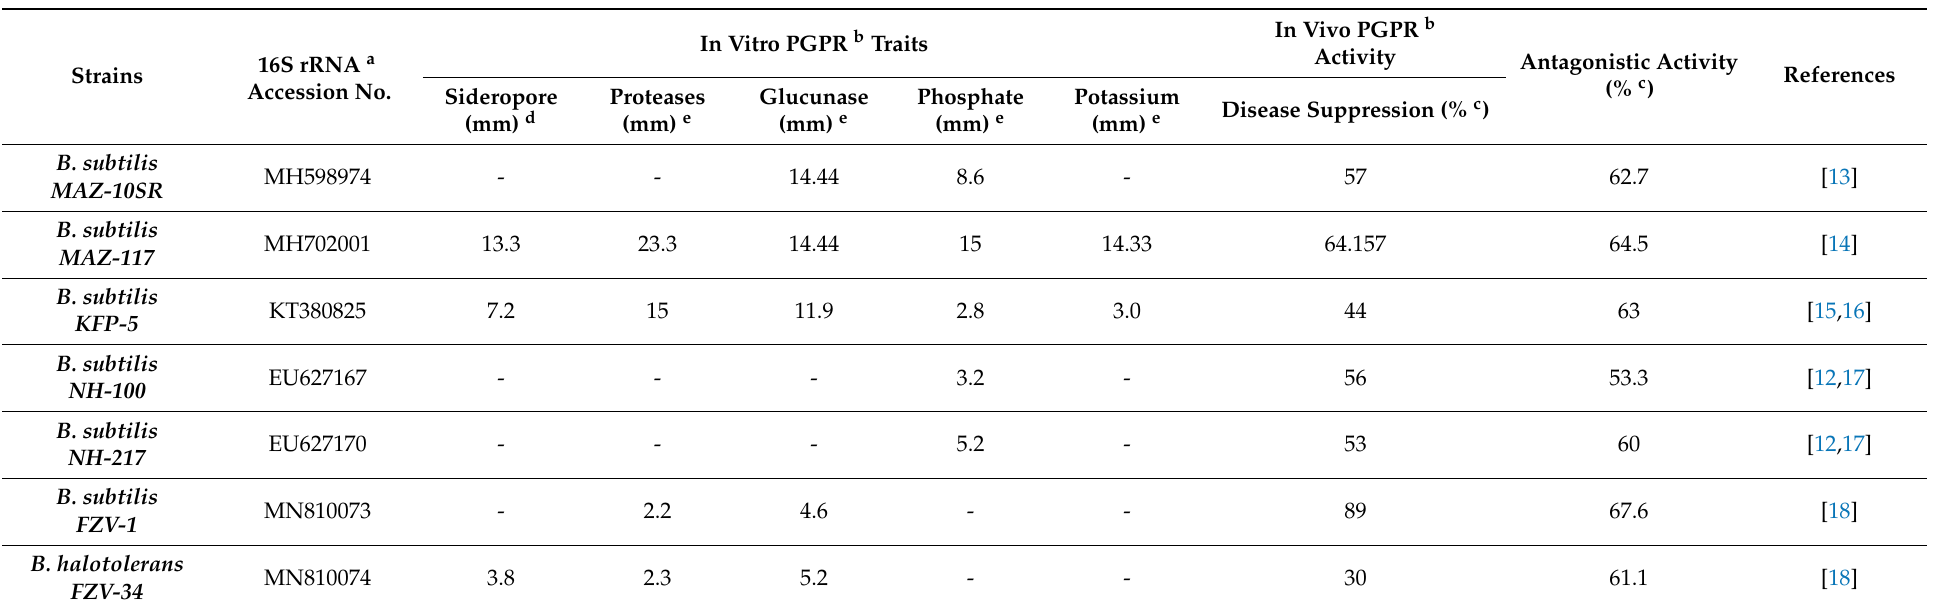
Table 1. Plant growth-promotional and antagonistic properties of Bacillus